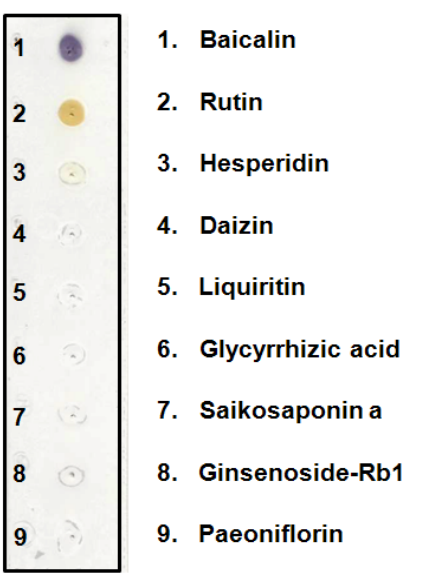
Figure 2. Dot blot analysis of BI and its specificity against various glycosides.